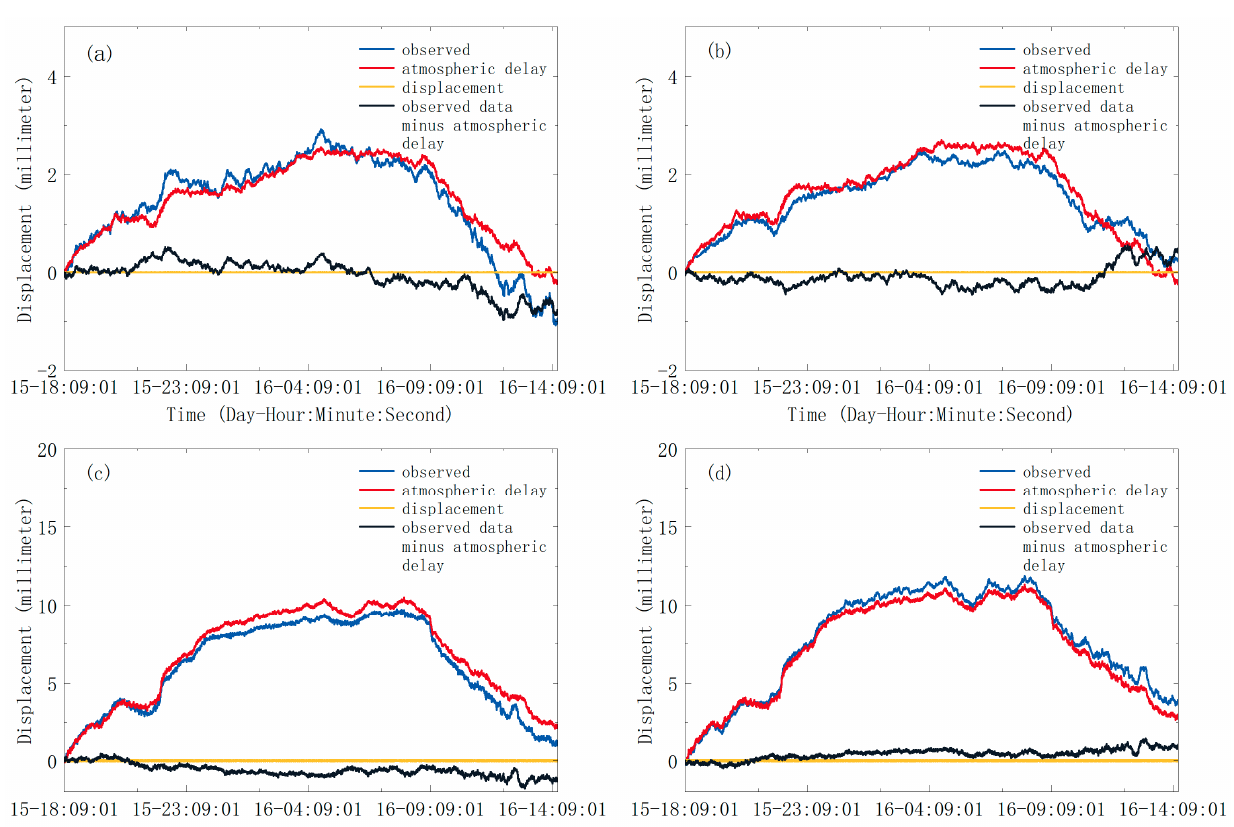
Table 1. The mean value, SD, and RMSE of the time series of the four re fl ectors. (All values in the table are expressed in millimeters).